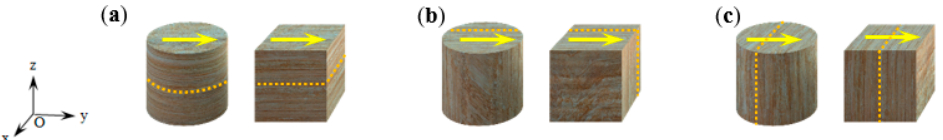
Figure 3. Radial resistivity testing method corresponding to three extremes. The arrow represents the current direction during the test, and the dotted line represents the lamination direction of the rock. θ is an included angle between the lamination plane and the end, and φ is an included angle between the projection of the lamination plane on the end and the current direction: ( a ) Extreme 1: θ = 0, φ = 0; ( b ) Extreme 2: θ = π /2, φ = 0; ( c ) Extreme 3: θ = π /2, φ = π /2.